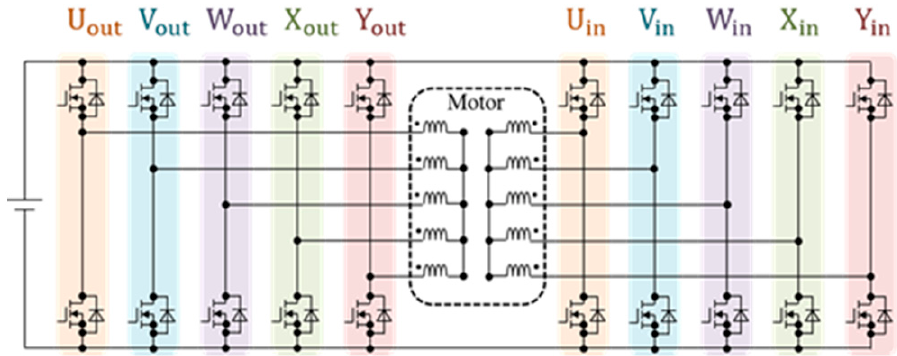
Figure 5. Inverter structure for 5-phase motor. SiC half-bridge module in Figure 2 is used for each